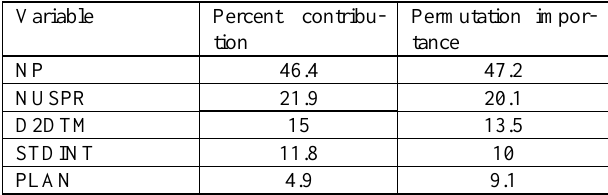
Table 3 Results of the jackknife test showing the importance of a variable.